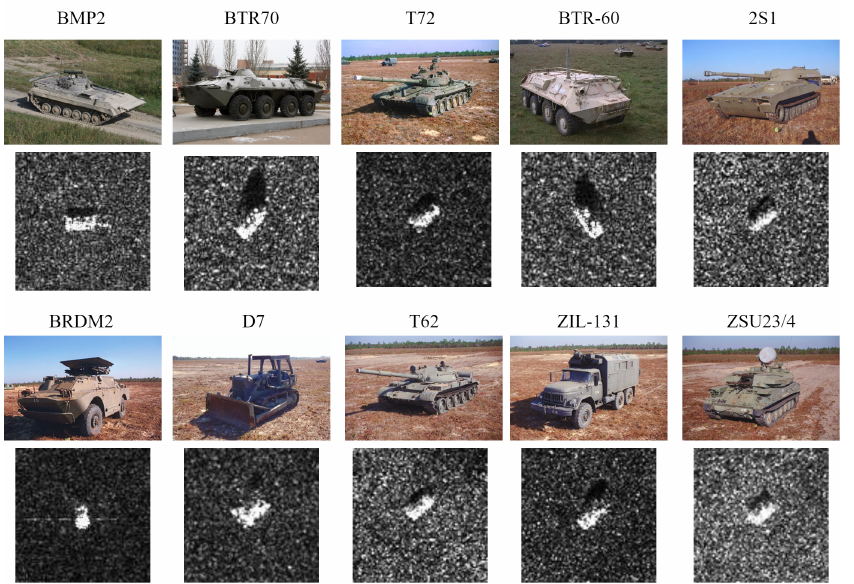
Figure 1. Examples of MSTAR training samples. The MSTAR dataset contains a total of ten targets of various vehicle types. The optical photographs of the targets are shown above their corresponding SAR image.